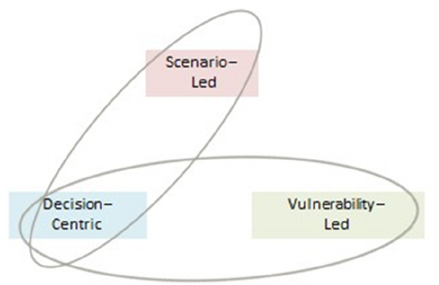
Figure 6. Hybrid of frameworks utilised in climate change adapta- tion projects in the neighbourhood of Sizewell nuclear power sta- tion, Suffolk, UK.